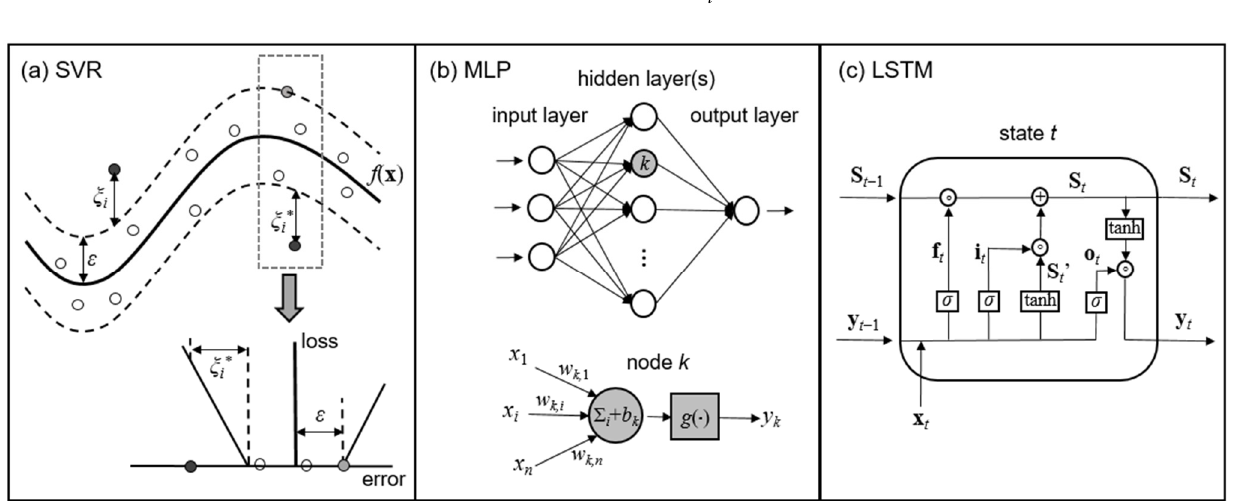
Figure 3. Sketches of the ML algorithms: ( a ) SVR (regression function and penalized loss); ( b ) MLP (network architecture and neuron sketch); ( c ) LSTM (sketch of a memory cell).